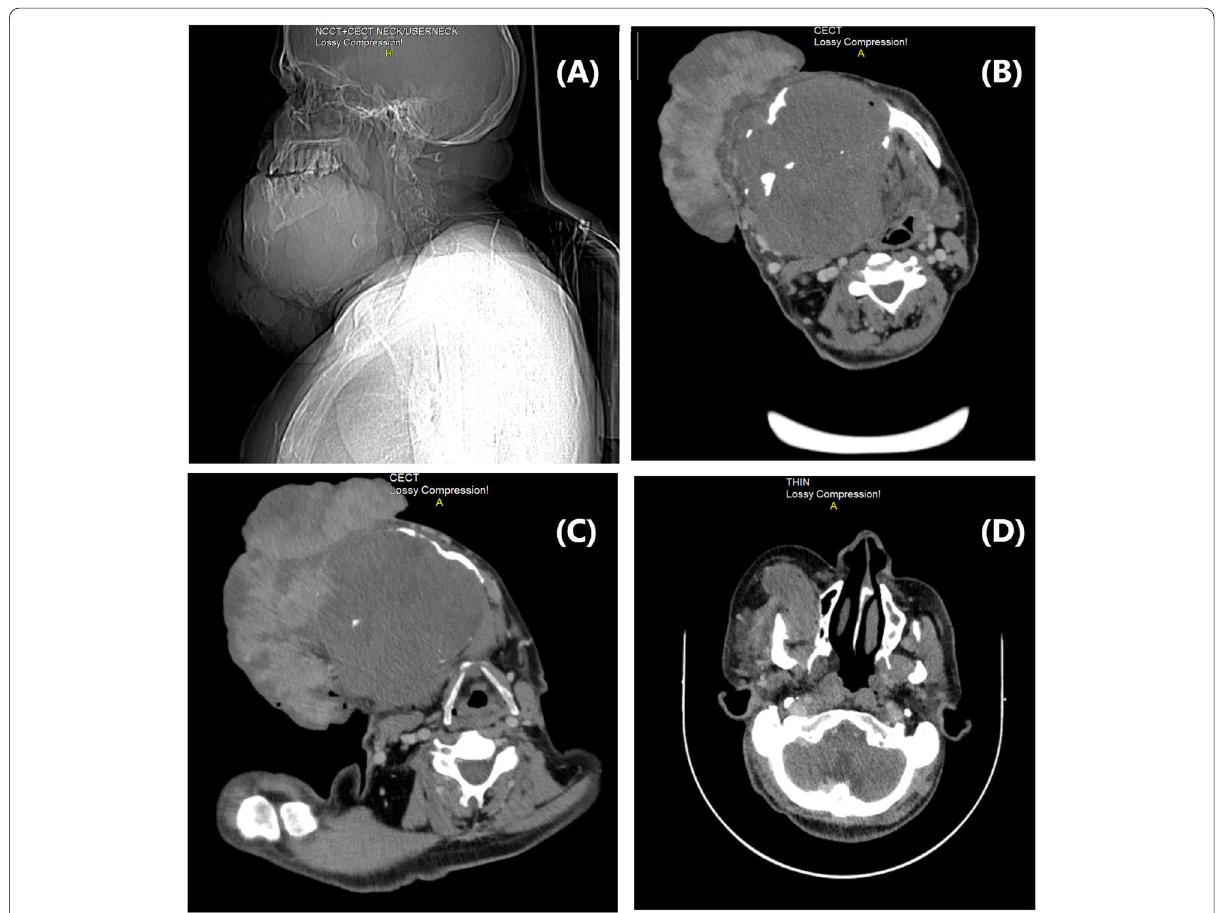
Fig. 1 CT scan images of patients showing a extent of tumor involving the lower jaw on the lateral view, b heterogeneous tumor causing destruction of the lower jaw on the right side crossing midline with major vessels of the neck which are normal, c tumor extension till the hyoid bone in the neck, and d tumor extending superiorly till the floor of the maxillary sinus and right cheek